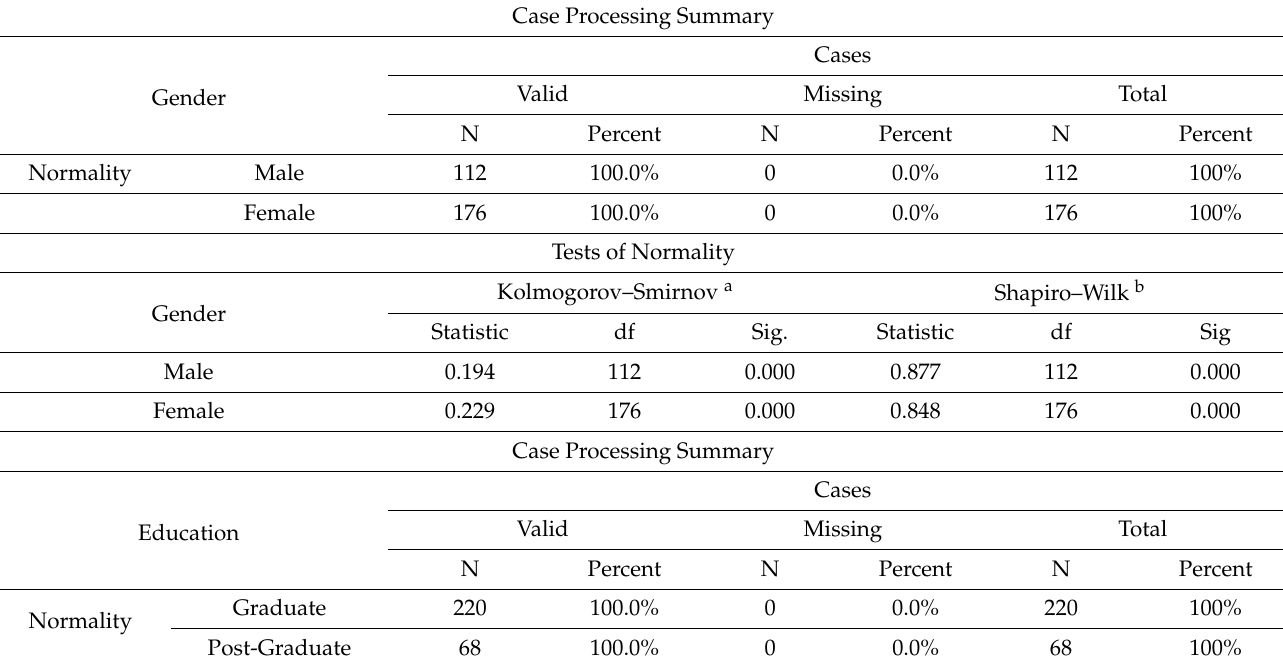
Table A5. Kolmogorov–Smirnov a and Shapiro–Wilk b Test for